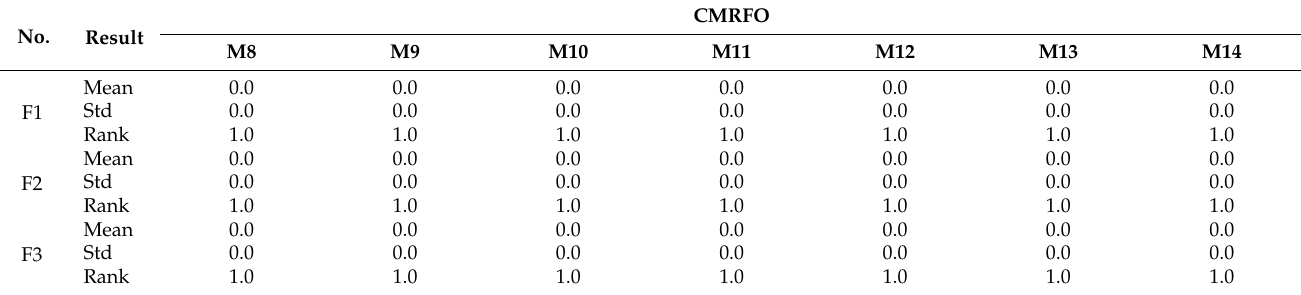
Table 3. Results of CMRFO using 14 different chaotic maps to initialize the population